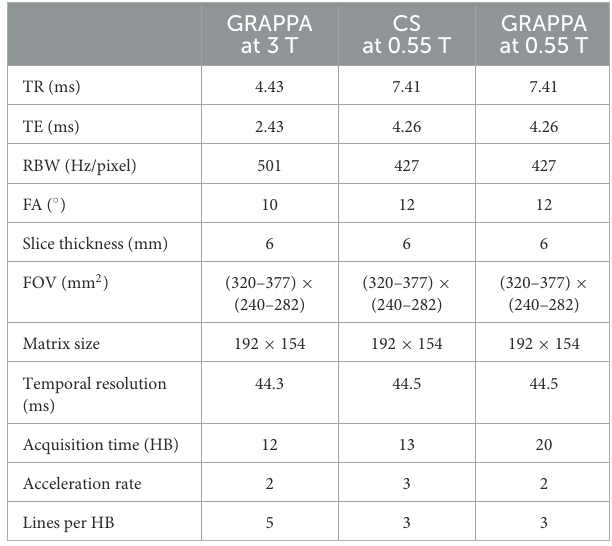
TABLE 2 Acquisition parameters of phase contrast MR images for 0.55T in comparison to